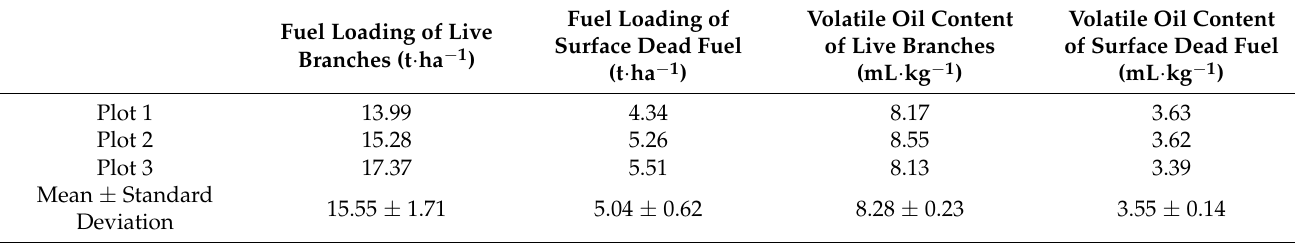
Table 2. Fuel loading and volatile oil contents in live branches and surface dead fuel of P. yunnanensis in three